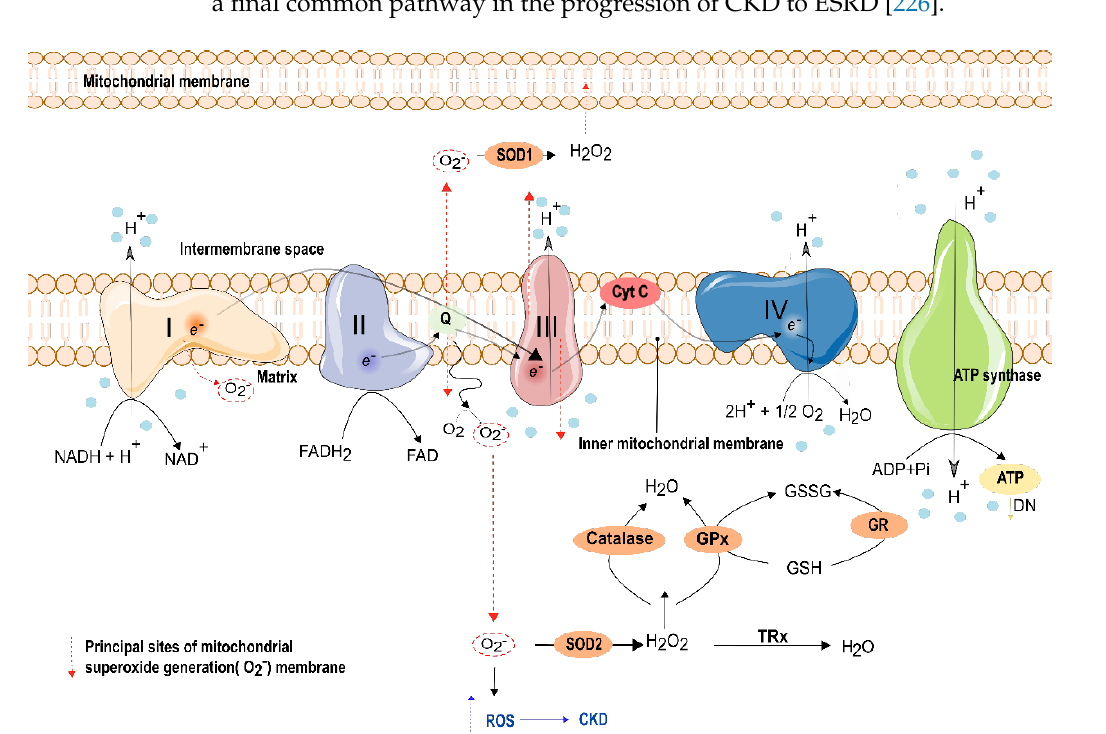
Figure 3. Mitochondrial oxidative phosphorylation and the mechanism of the main antioxidant enzymes present in the kidney. Reducing equivalents (NADH, FADH 2 ) produced through the Krebs cycle donate electrons to the electron transport system at complex I and complex II. These electrons are subsequently transferred to other electron carriers, including coenzyme Q, complex III, cytochrome C (Cyt C), and complex IV. In complex IV, the oxygen is reduced into water. The donation of electrons provides the energy to pump protons (H + ), which is responsible for the establishment of the electrochemical proton gradient at the inner mitochondrial membrane. This phenomenon generates the proton motive force that forces the protons back inside the matrix at ATP synthase to regenerate ATP from ADP and Pi. In diabetic nephropathy (DN), the production is reduced. With physiological conditions, some part of the O 2 is converted into reactive oxygen species (ROS), where complexes I and III are considered the principal sites of ROS production. In the kidney, when the electron transport chain and mitochondria functioning is impaired, there is an imbalance between ROS and antioxidant activity, which may be a potentiator and contributor of kidney-related diseases such as chronic kidney disease (CKD), and DN. The main antioxidant enzymes are superoxide dismutase (SOD), catalase, glutathione peroxidase (GPx), and glutathione reductase (GR). SOD1 in the intermembrane space and SOD2 is released to the matrix. Levels of H 2 O 2 are reduced to water through the cooperation between the antioxidant enzymes schematically represented in the scheme.